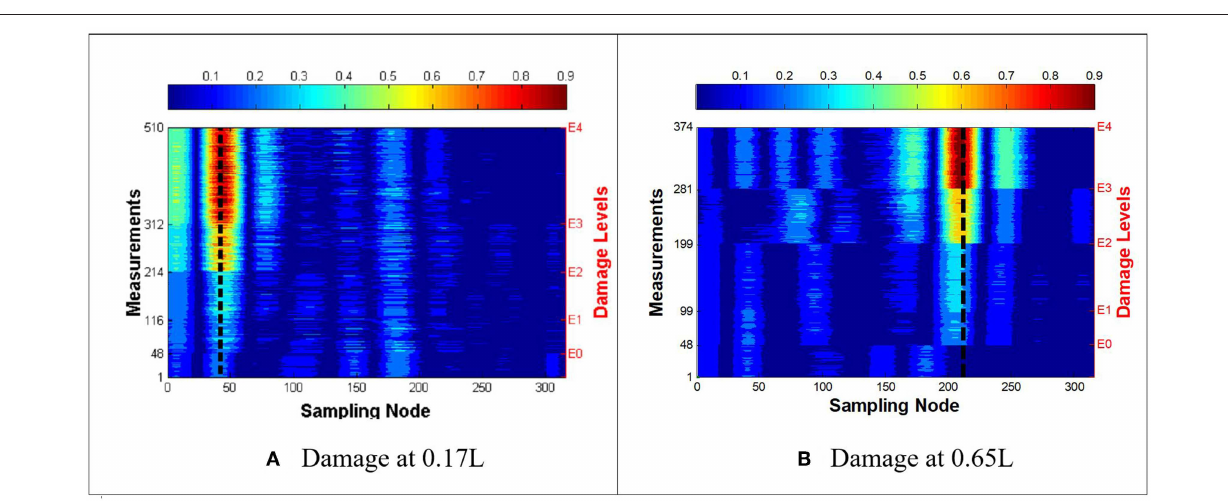
damage level using the data for states E 0 , E 1 , and E 2 for